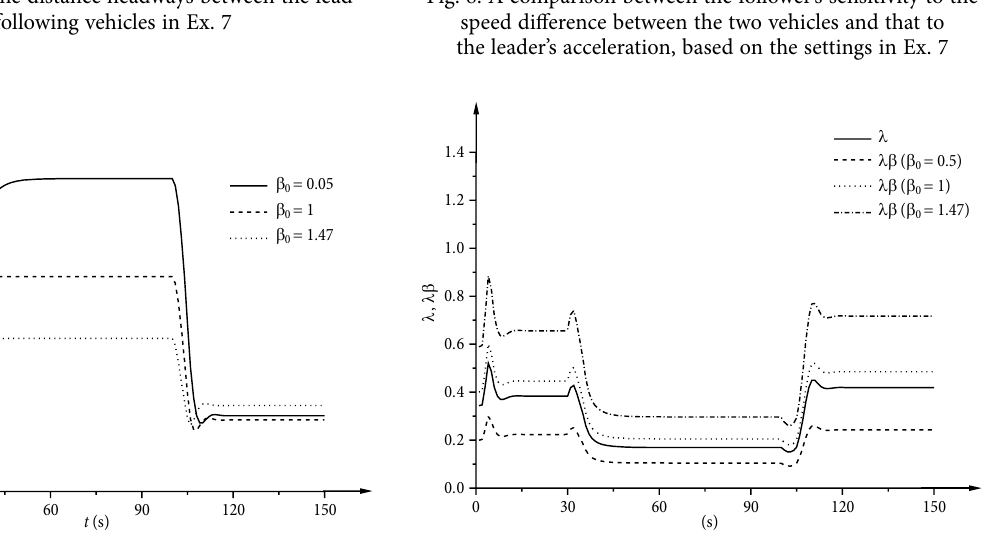
Fig. 9. Profiles of the distance headways between the two Fig. 10. A comparison between the follower’s sensitivity to vehicles in Ex. 8 the speed difference between the two vehicles and that to the leader’s acceleration, based on the settings in Ex.